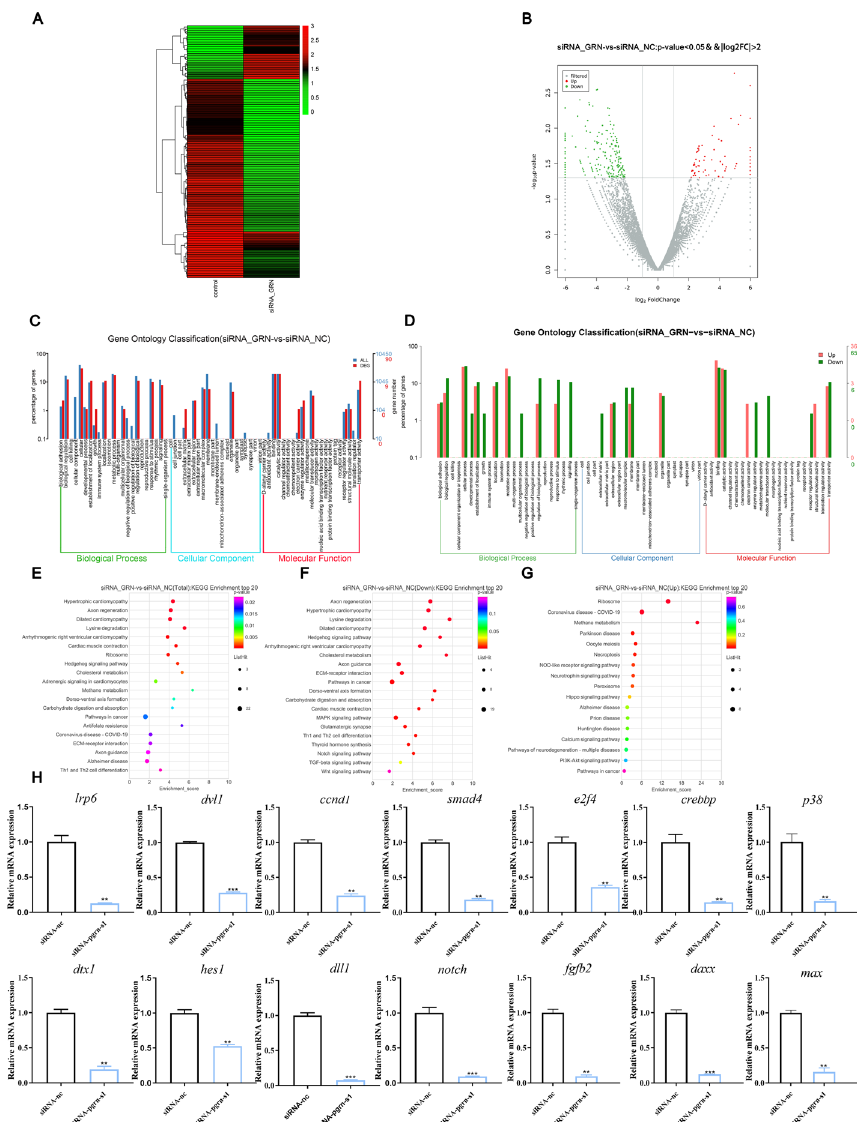
Fig. 3 Transcriptome analysis and signaling pathway validation after Lr-pgrn-s1 knockdown in embryonic cells. A Heatmap showing the expression of 100 genes in the control and experimental groups. Color intensity indicates expression levels. The color scale adjacent to the heatmap indicates the raw Z -score, ranging from green (low expression) to red (high expression). The similarity between individuals with hierarchical clustering is shown above the heatmap. B Volcano plot of differentially expressed genes (DEGs) between the experimental and control groups. DEGs with p -value < 0.05 and |log 2 FC| > 2 were screened. One dot indicates one gene, red dots represent upregulated genes, green dots represent downregulated genes, and black dots indicate undifferentiated genes in the volcano. The smaller the q- value, the larger the log( q -value), and the more significant the gene differentially expressed between the experimental − and control groups. C , D GO analysis of the transcriptomic data of Lr-pgrn-s1 knockdown of embryonic cells. The histogram presentation of GO classification indicates transcripts in numbers after being annotated in three groups: CC, MF, and BP. E – G KEGG analysis of upregulation and downregulation of TOP20 in the transcriptome of embryonic knockdown Lr-pgrn-s1 . The top enrichment pathways are presented in the advanced bubble chart. The X -axis label represents the enrichment score, while the Y -axis label represents the pathway. The size of the bubble represents the number of genes enriched in the KEGG terms, while the color represents the FDR P -value of KEGG terms. H qRT-PCR analysis of genes related to the MAPK, Notch, Wnt, and TGF-β signaling pathways. Mean SD is shown ( n 3 per group). The probability of statistical differences ± = between the experimental groups was determined using Student’s t -test. * P < 0.05, ** P < 0.001, *** P <